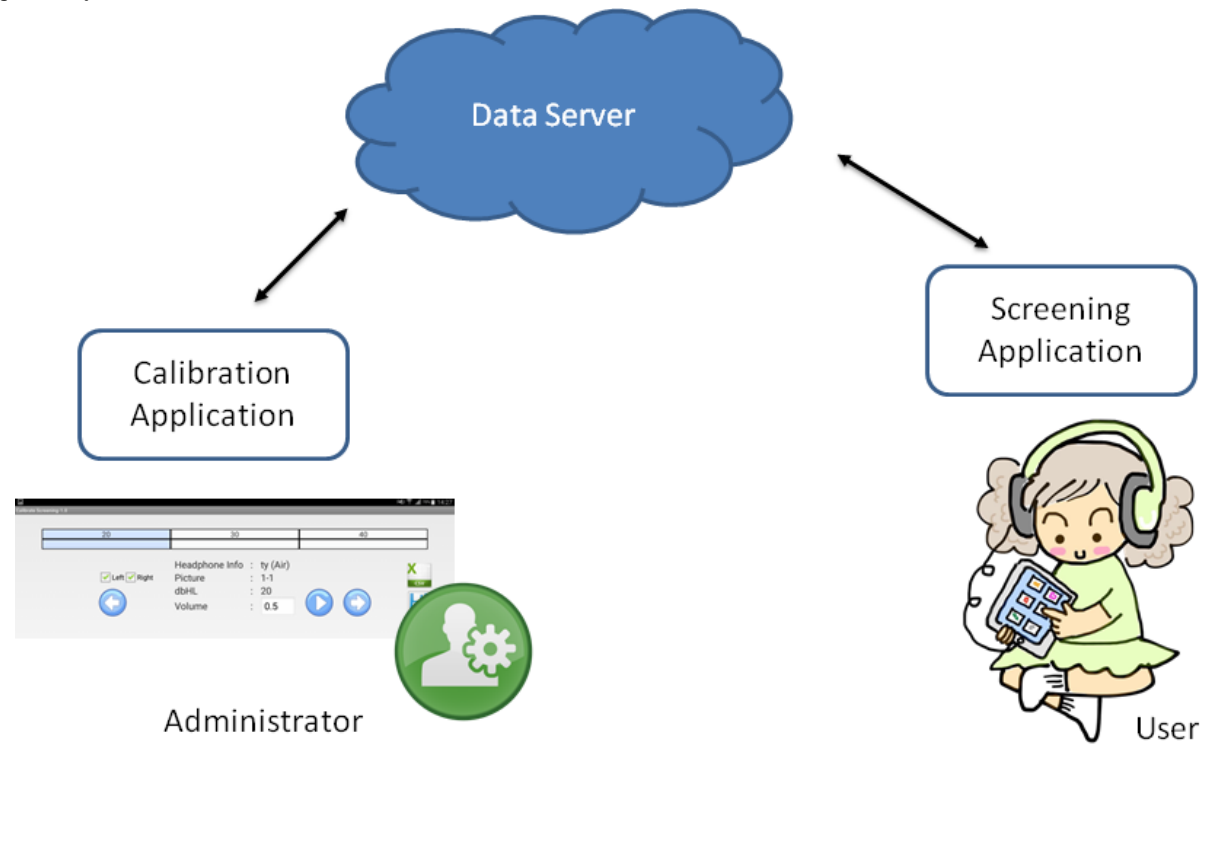
Figure 1. System